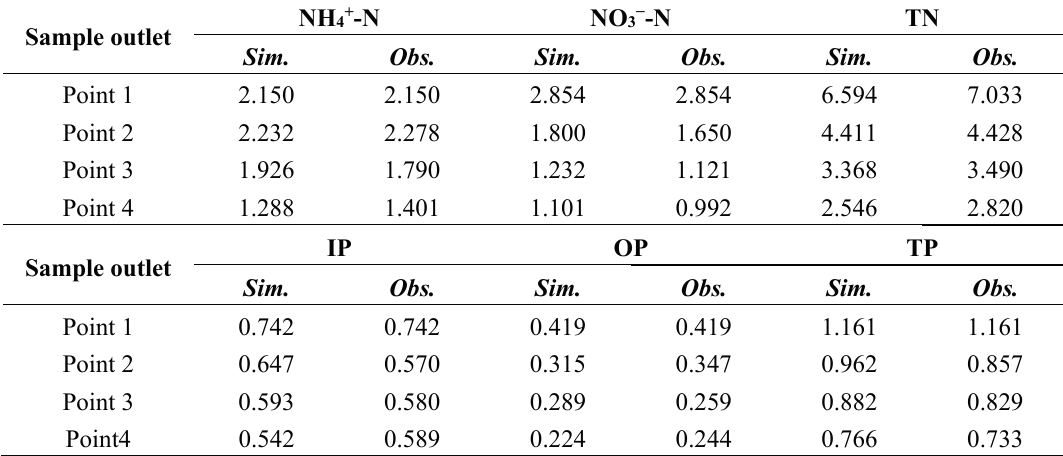
Table 5. Comparison of simulated and observed data